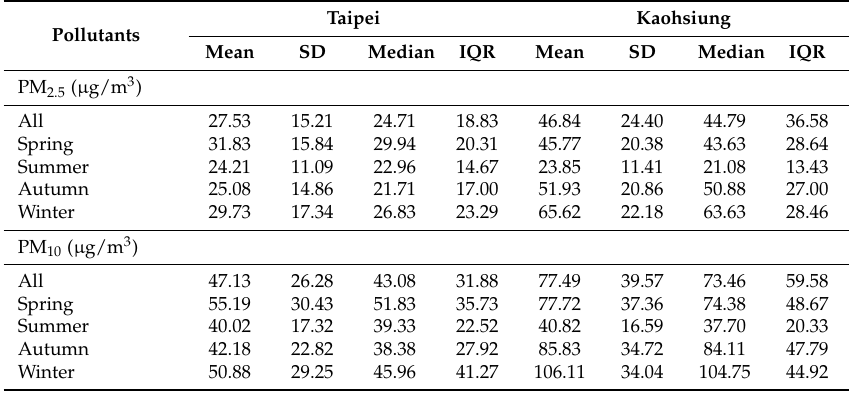
Table 2. Summary statistics for air pollutants in Taipei and Kaohsiung, Taiwan,